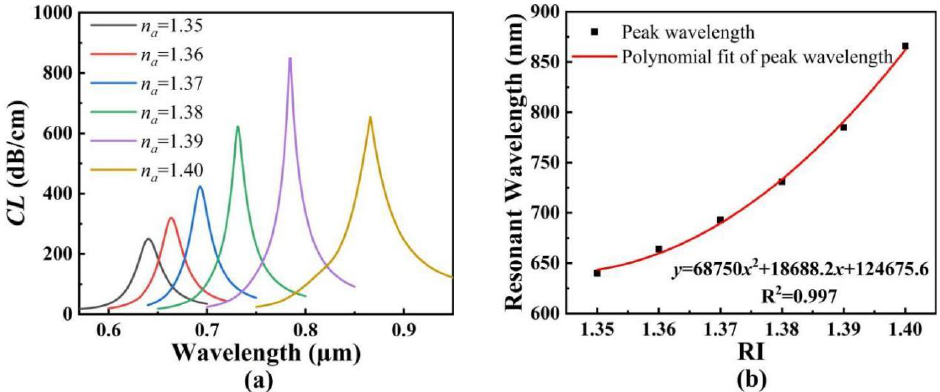
Figure 10. ( a ) The CL spectra of the core mode A. ( b ) The variation of the resonant wavelength of the core mode A with the analyte RI and its fitting result.